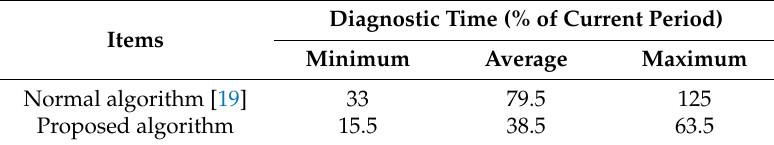
Table 4. Results about the diagnostic